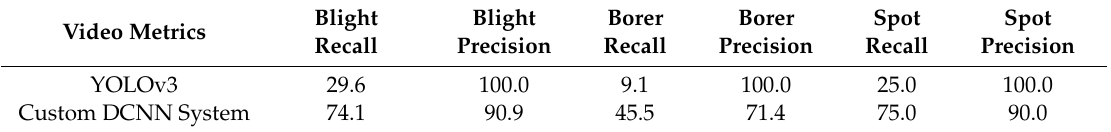
Table 9. Video metrics of YOLOv3 and our system using Video 1 (%) 1